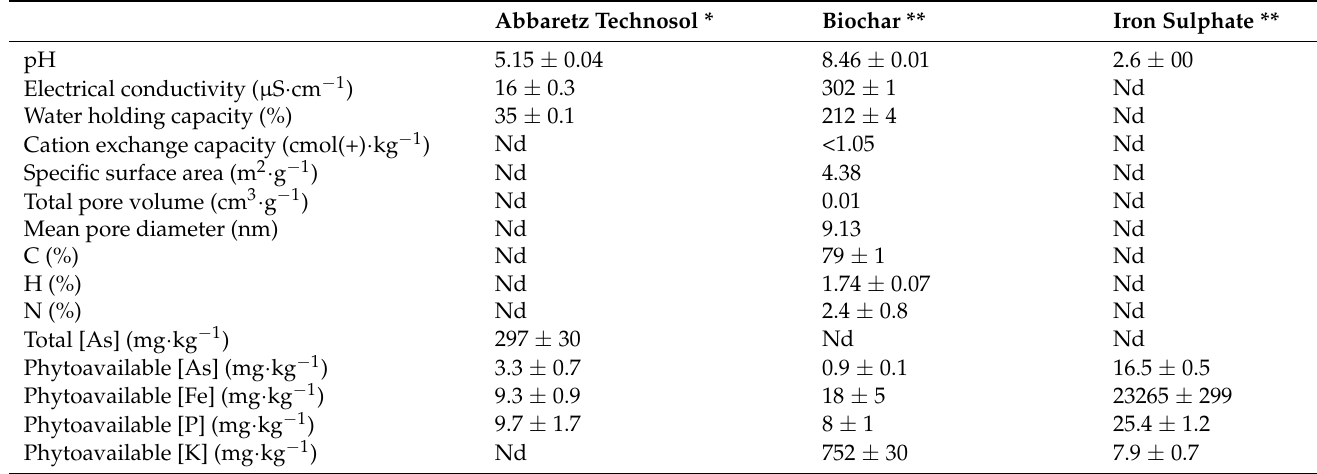
Table 1. Physico-chemical properties of the soil and the